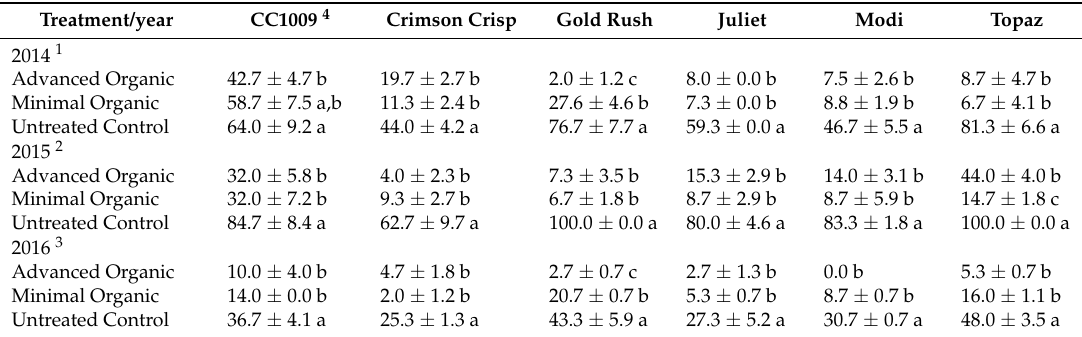
Table 5. Development of sooty blotch and flyspeck in selected varieties under different